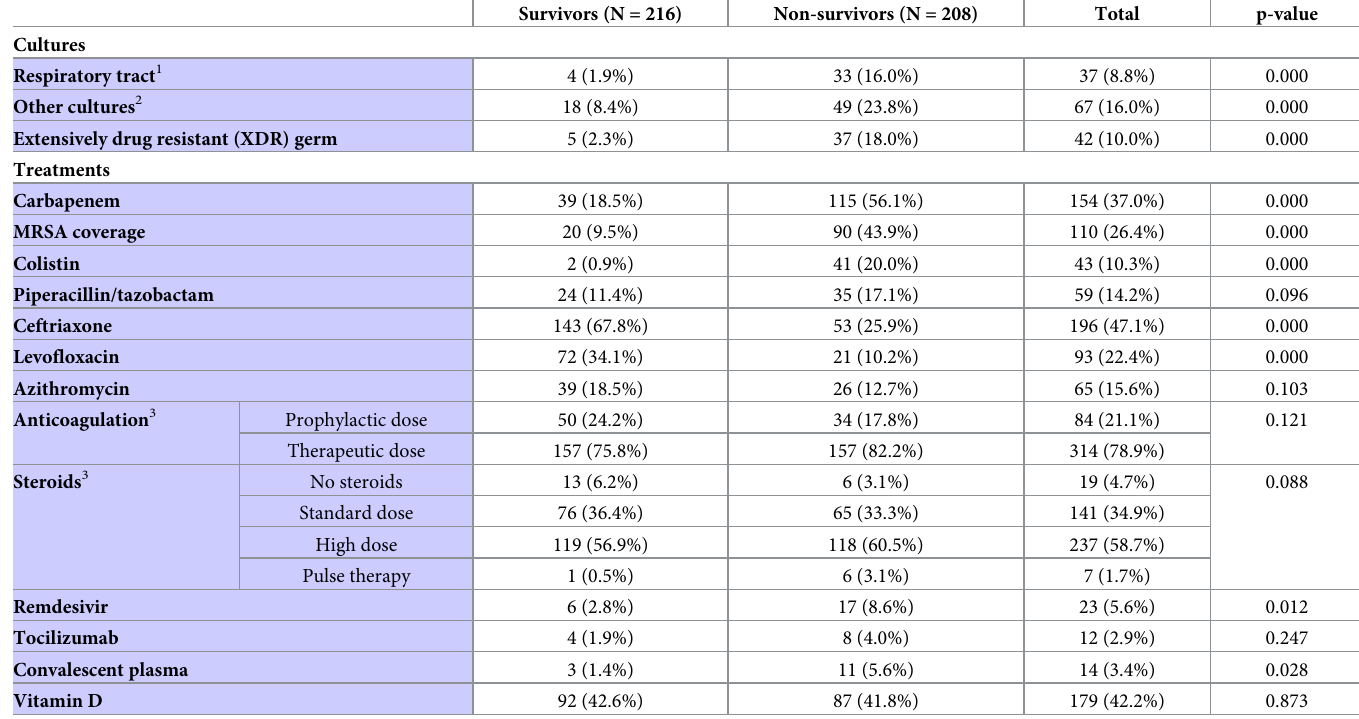
Table 3. Rate of bacterial superimposed infections and treatments administered (LINE